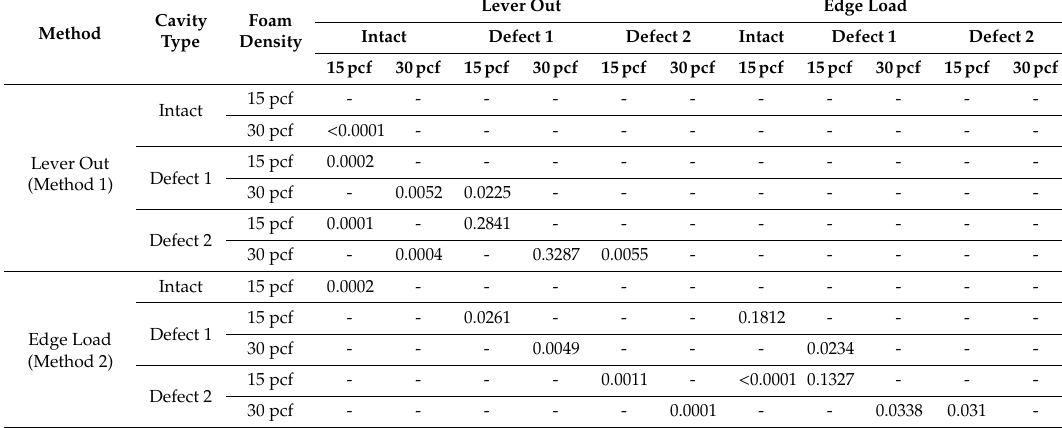
Table 2. Tabular listing of the p -values (Welch’s ANOVA with Games–Howell post-hoc test) determined for the parameter Moment M for the various combinations of foam density, cavity type, and test method. The values of p < 0.05 were defined as significant. The group of the intact cavity and 30 pcf foam density for Method 2 was excluded, because the group consisted of only one